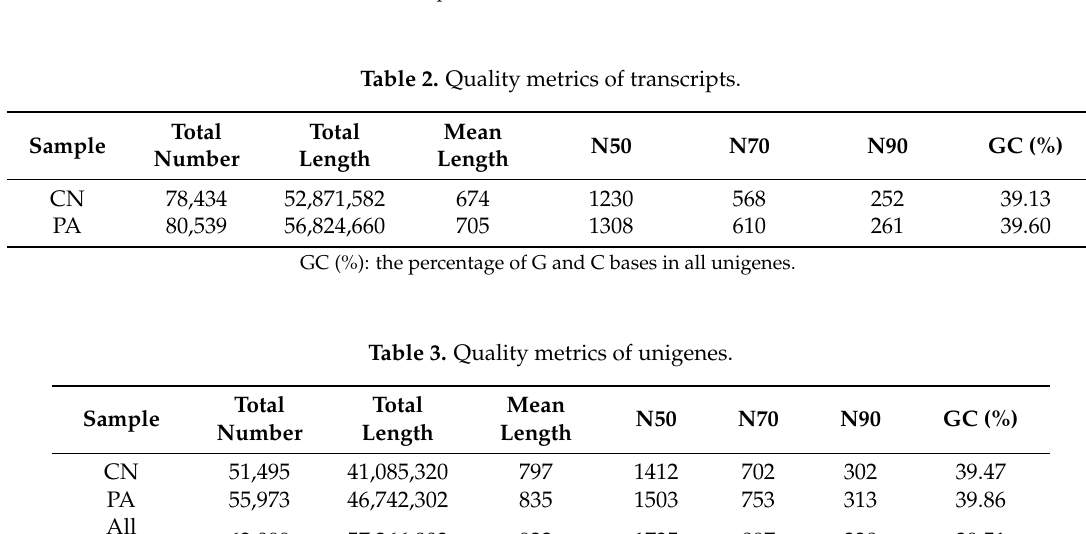
Table 1. Summary of sequencing reads after filtering.